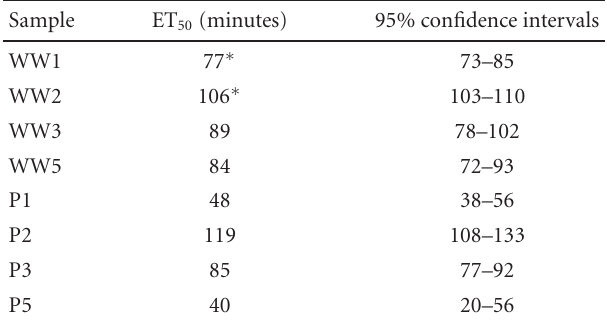
Table 1: Summary of ET 50 values. The proportional data were arcsine square root transformed and the ET 50 calculated using maximum-likelihoodprobit or logit analysis.WW1–WW5:samples of watercress wash water. P1–P5: samples of PEITC solution.